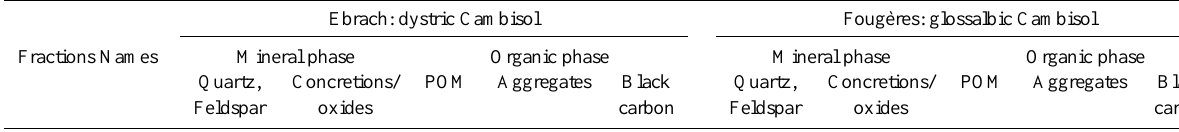
Table 3. Visual description of